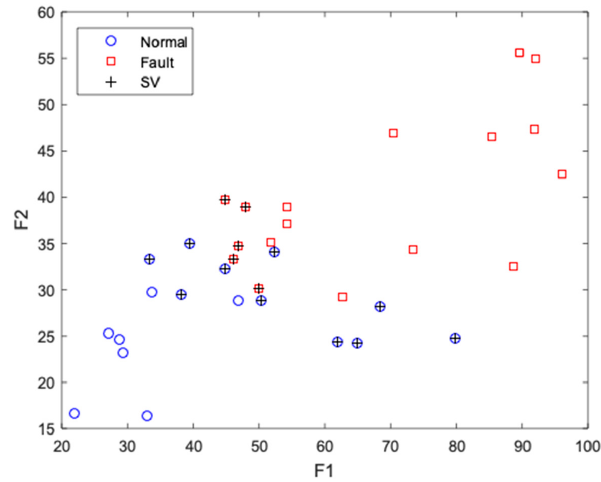
Figure 12. Sample points and support vectors by F1 and F2 .